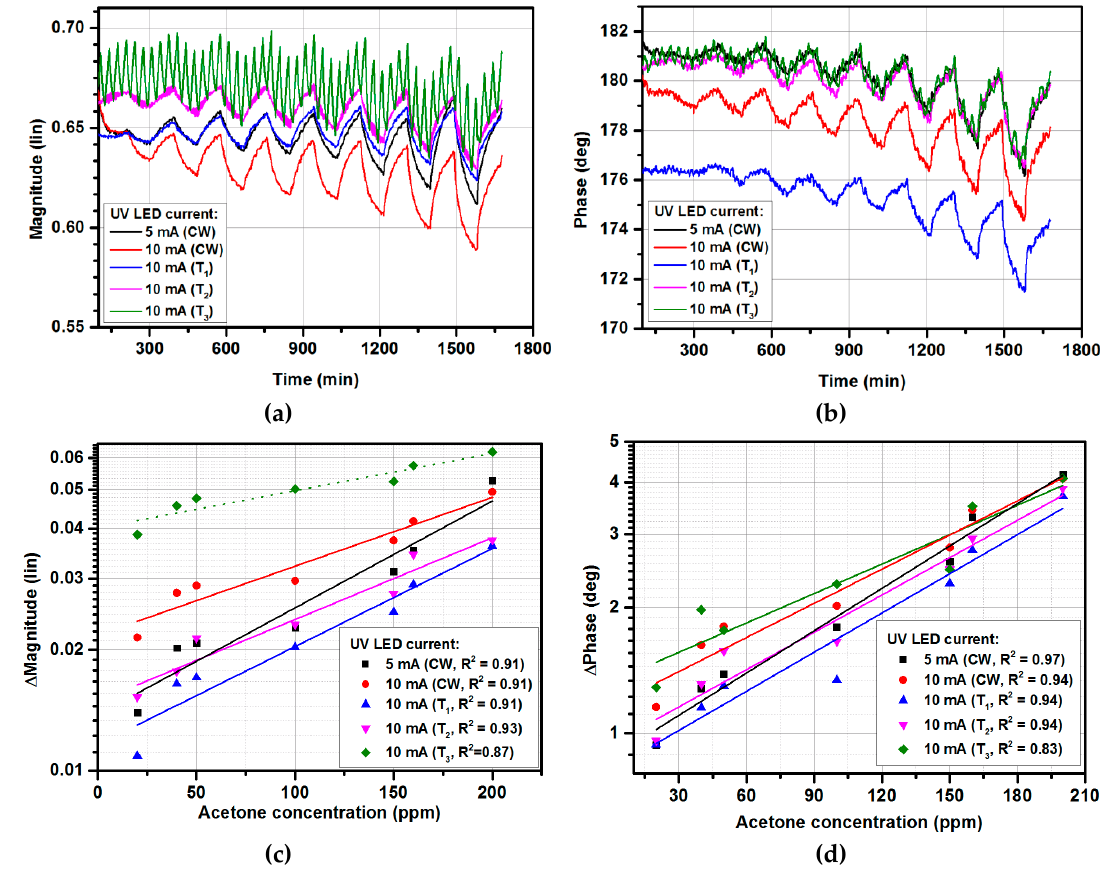
Figure 4. The gas-sensing characteristics under exposure to acetone in the 0–200 ppm range: ( a ) magnitude changes in time; ( b ) phase changes in time; ( c ) calibration curve for magnitude changes; ( d ) calibration curve for phase changes.